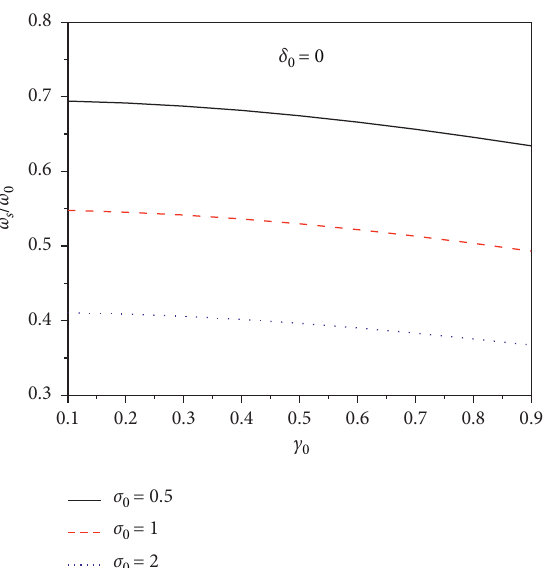
fs / ω s with respect to σ 0 for � 0 and l � with δ 0 0 0